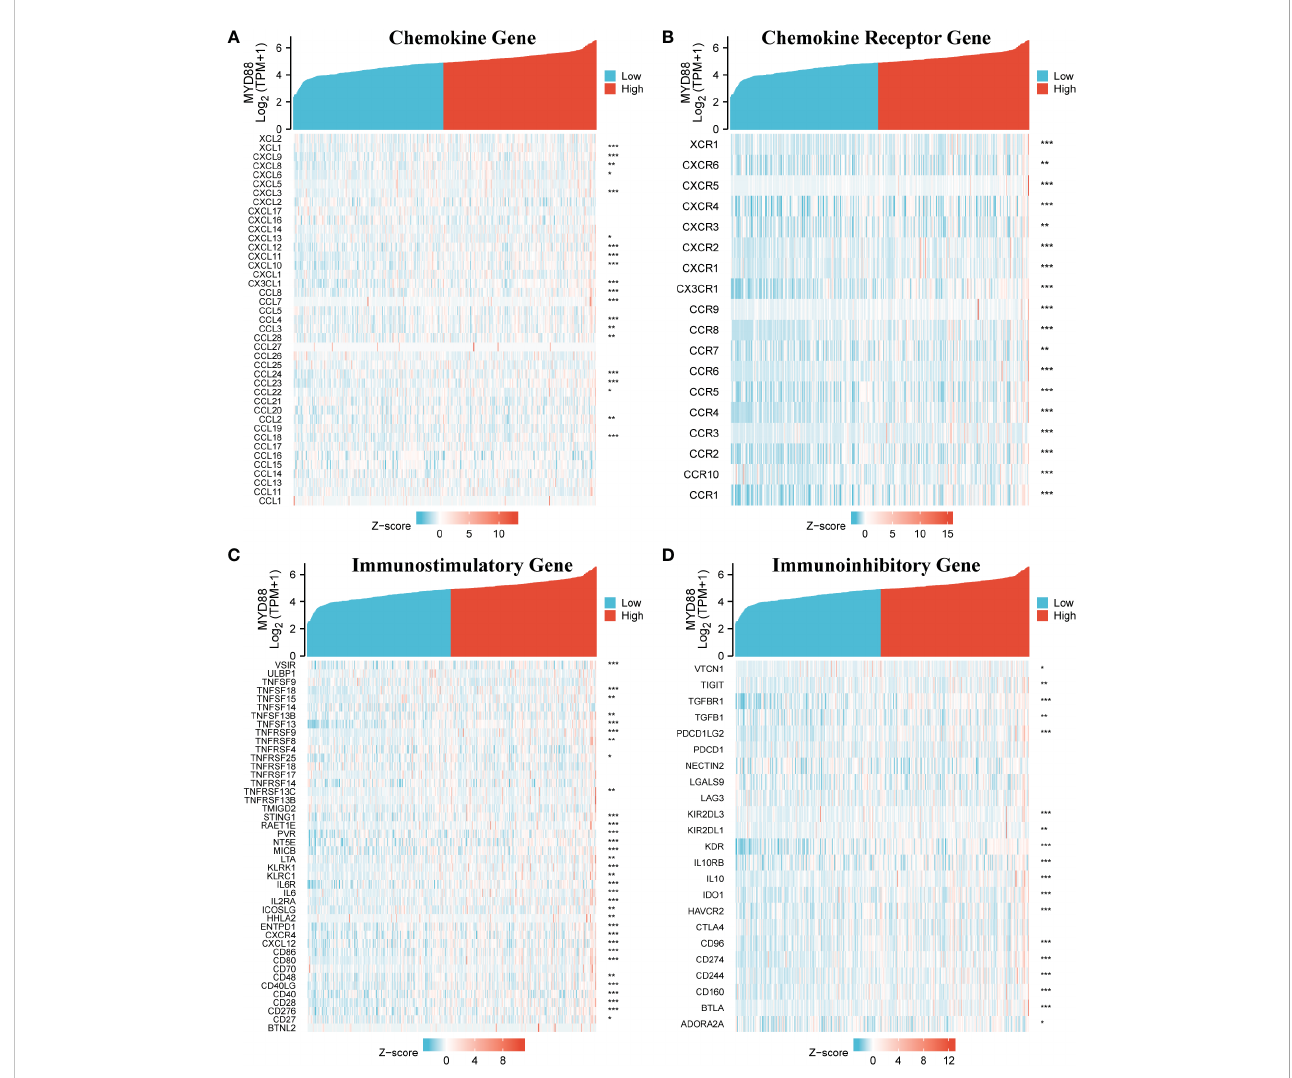
FIGURE 5 The relationship between MyD88 and immune-related genes. (A) The relationship between MyD88 and chemokine genes. (B) The relationship between MyD88 and chemokine receptor genes. (C) The relationship between MyD88 and immunostimulatory genes. (D) The relationship between MyD88 and immunoinhibitory genes. * P < 0.05, ** P < 0.01, *** P <